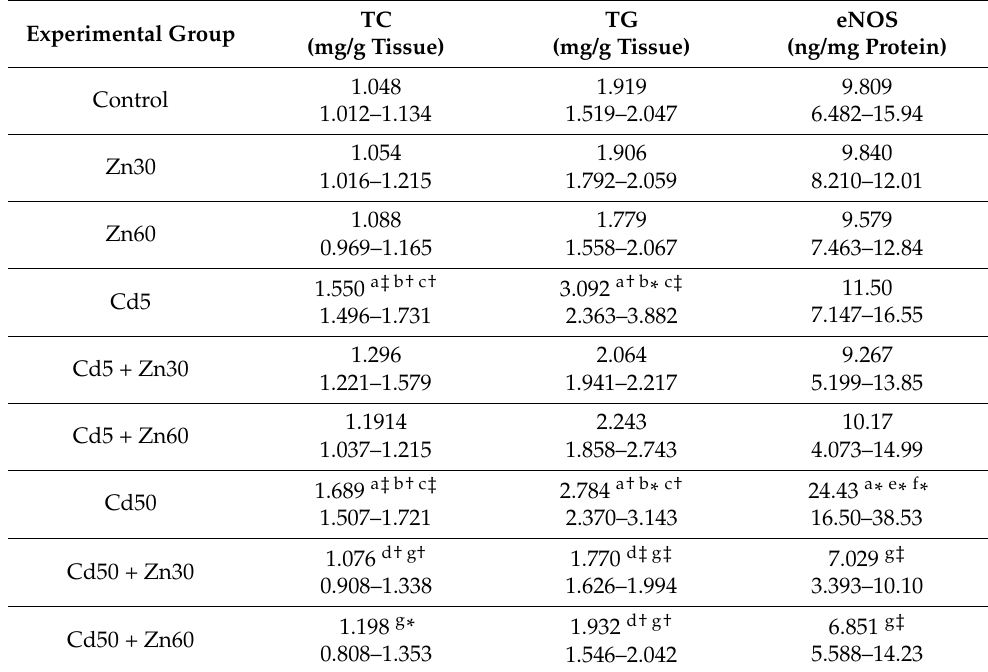
Table 3. The concentrations of TC, TG, and eNOS in the vascular tissue of the abdominal aorta in particular experimental groups 2